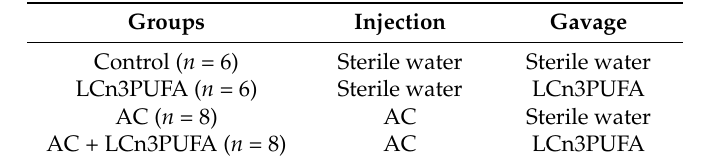
Table 1. List of treatment groups for the animal trial. Groups Injection